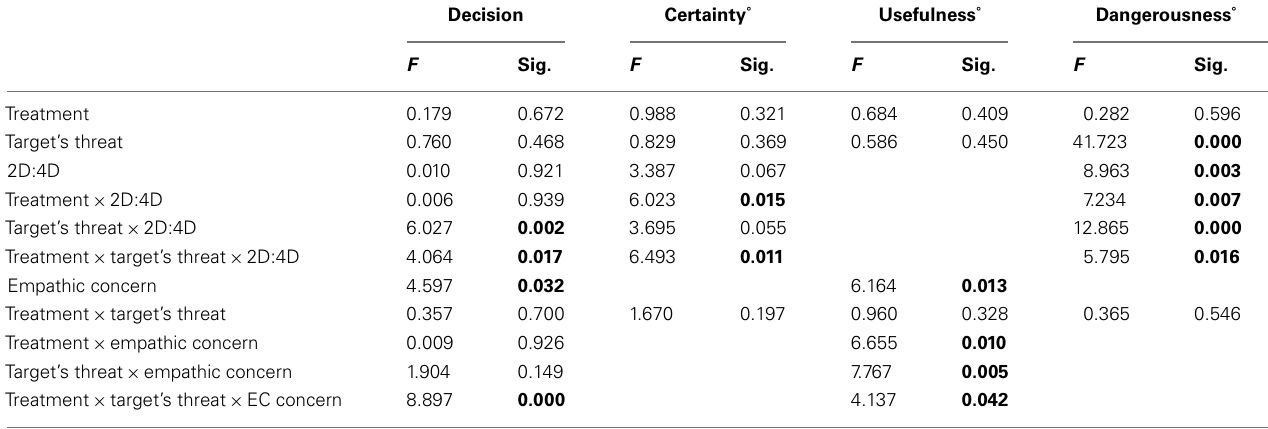
Table 1 |Tests of model